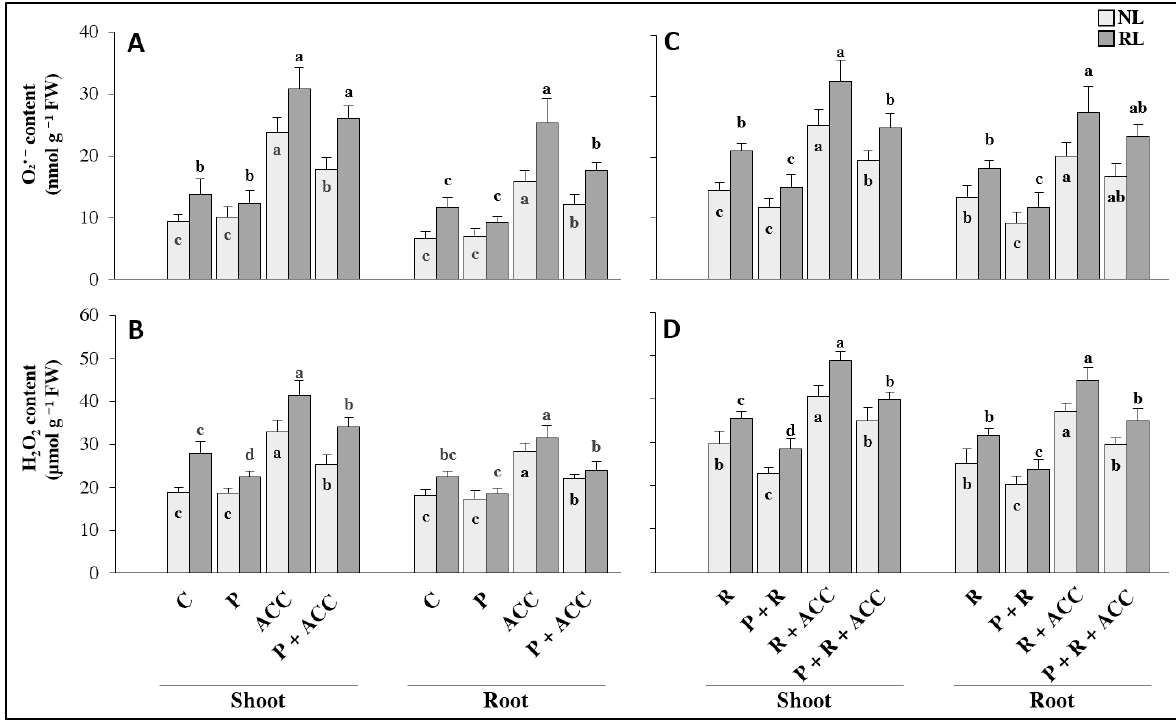
Figure 2. Effect of P. thivervalensis strain T124 inoculation and exogenous ACC on O 2 •− and H 2 O 2 accumulation in clover shoot and root under normal and reduced light conditions. (Plots ( A , B ) refer to experiment 1. Plots ( C , D ) refer to experiment 2. C, Control treatment; P, plant inoculated with P. thivervalensis strain T124; R: inoculated with R. leguminosarum strain T618; ACC, exogenous ACC; NL, Normal light condition; RL, Reduced light condition. Treatment columns in each light condition followed by different letters are significantly different ( p < 0.05). The error bar represents the standard error of the mean ( n = 4)).